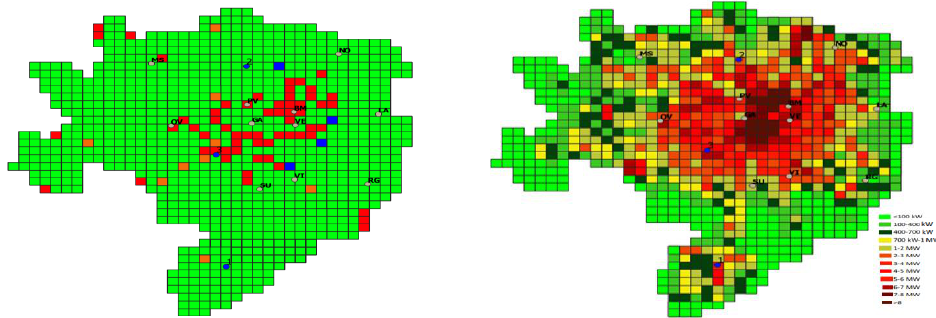
Figure 19. Output of the simulation results considering three new PSs. Blue points are the new PSs, while gray is the existing ones.